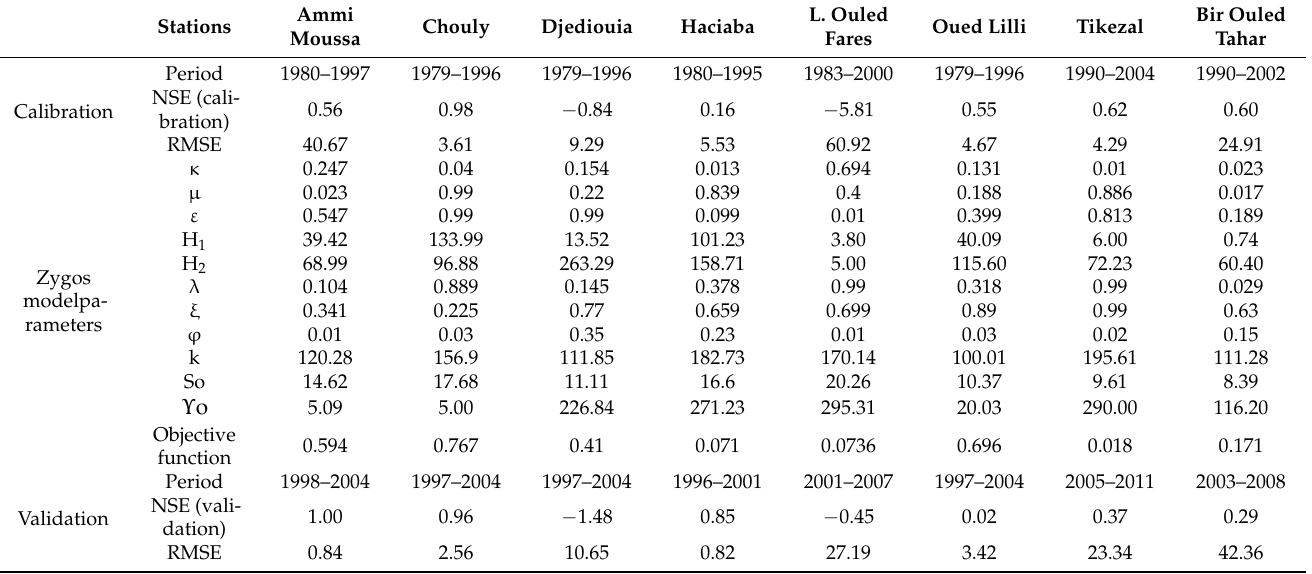
Table 3. Parameters of the manual calibration of the rainfall–runoff model Zygos (Reprinted Table 4. Simulation parameters.